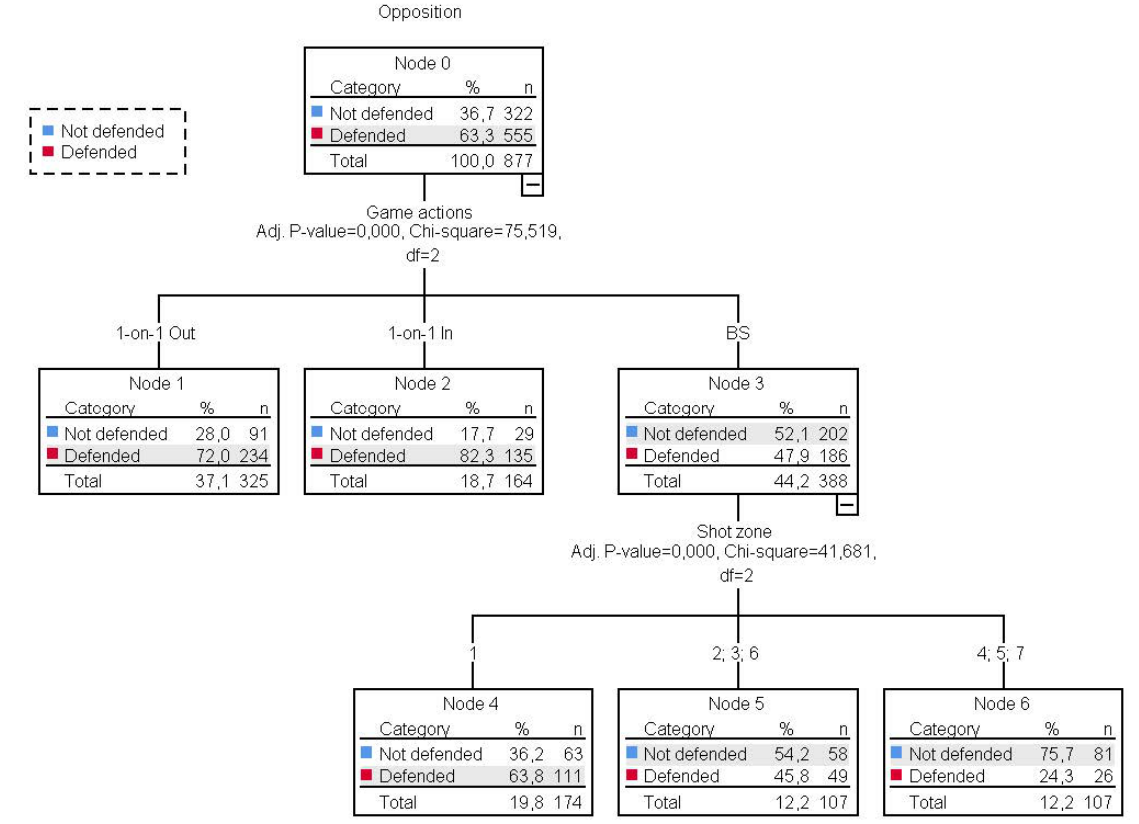
Figure 5. Game actions (1-on-1, Ball Screen) and shot zone as predictive variables in the level of opposition. The tree identified two predictive variables: the game actions and the zone from where the shots were